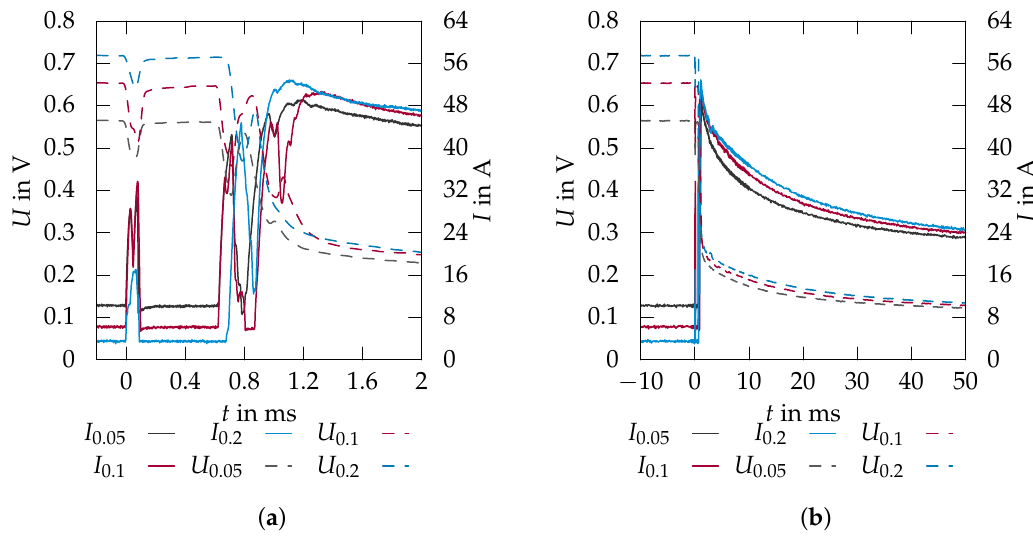
Figure 12. Current (solid) and voltage (dashed) measurements [14] for all load variations (0.05 Ω (black), 0.1 Ω (red) and 0.2 Ω (red)) in the experiment ( a ) during the switching of the relay and ( b ) until 50ms.